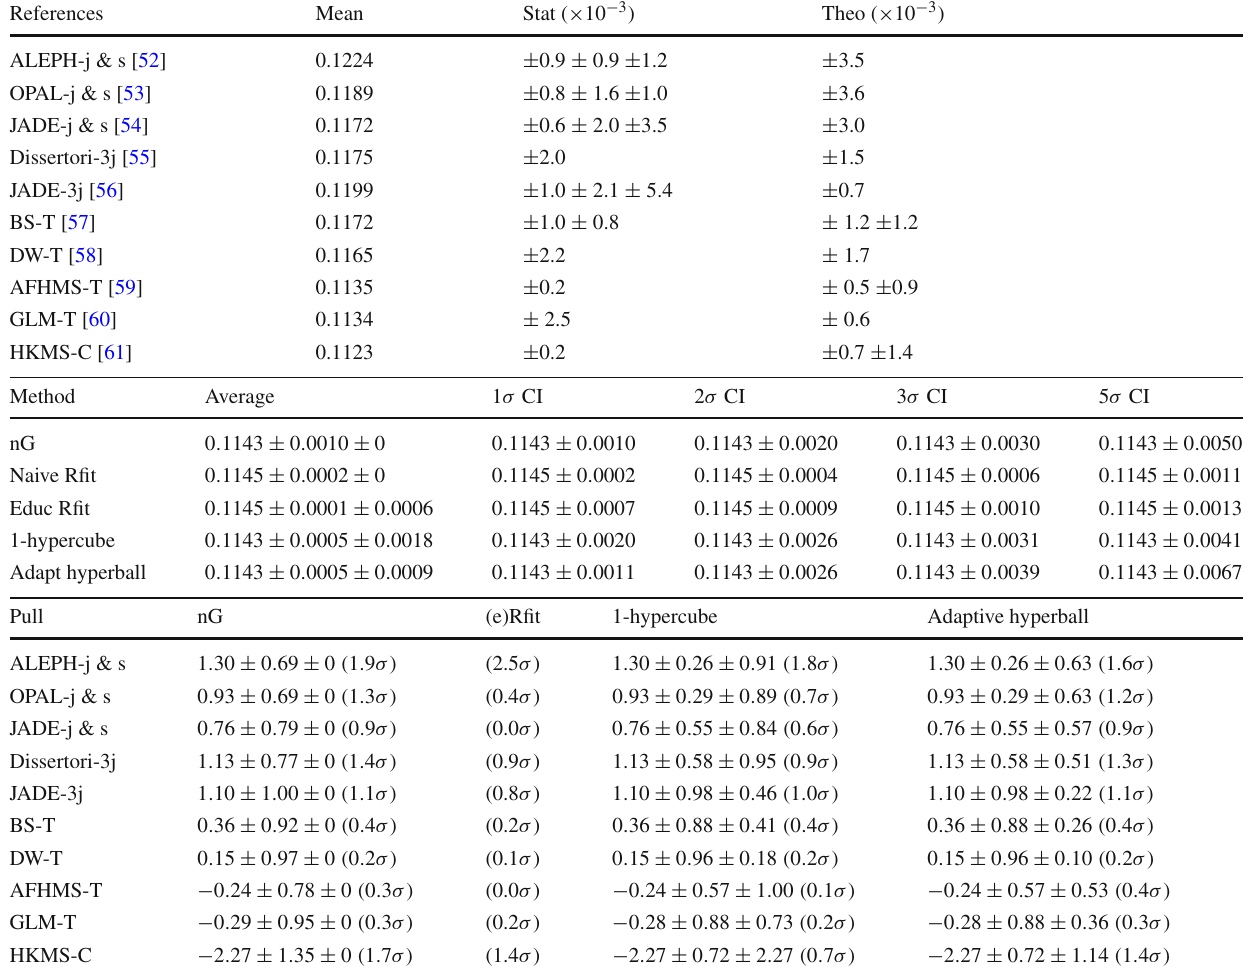
Table8 Top:determinationsof α S ( M Z ) using e + e − annihilation,taken from Ref. [34]. Middle: averages for α S ( M Z ) from e + e − annihilation according to the various methods, and corresponding confidence inter- vals for various significances. Bottom: pull associated to each measure-